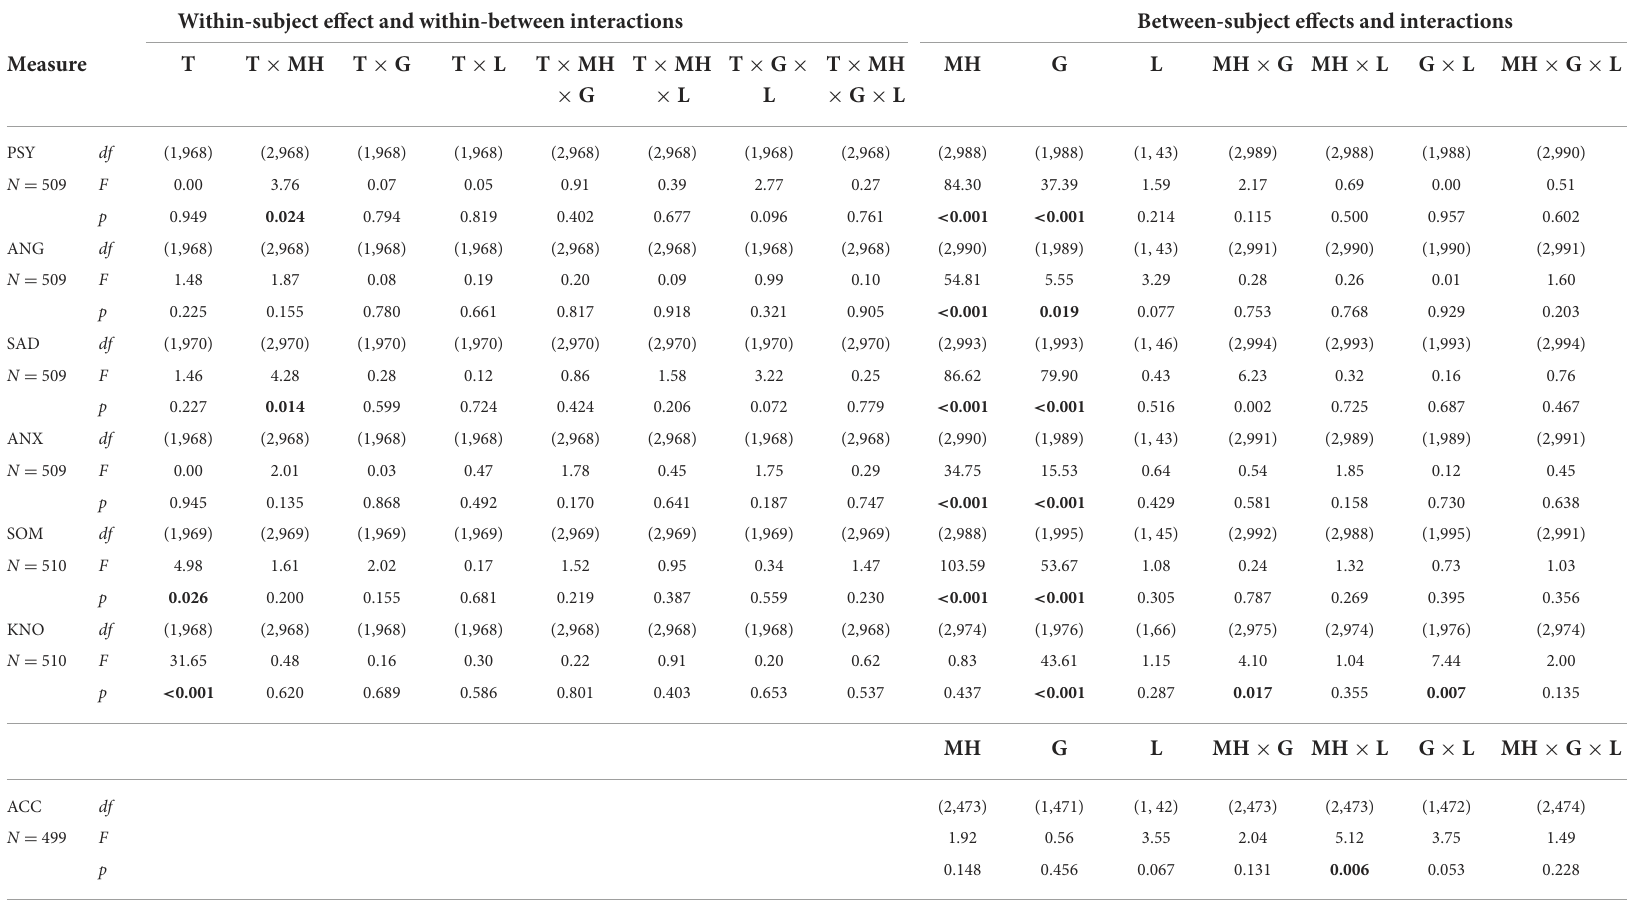
TABLE 2 Summary of fixed effects of the mixed effects model (Satterthwaite’s